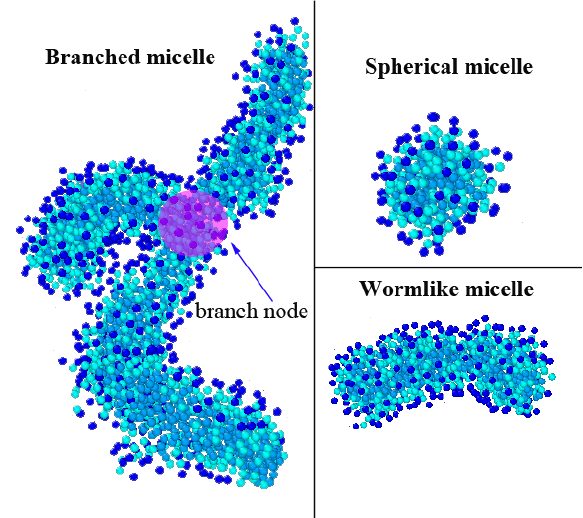
Figure 10. Example of a branched micelle, branch node, spherical micelle, and wormlike micelle.